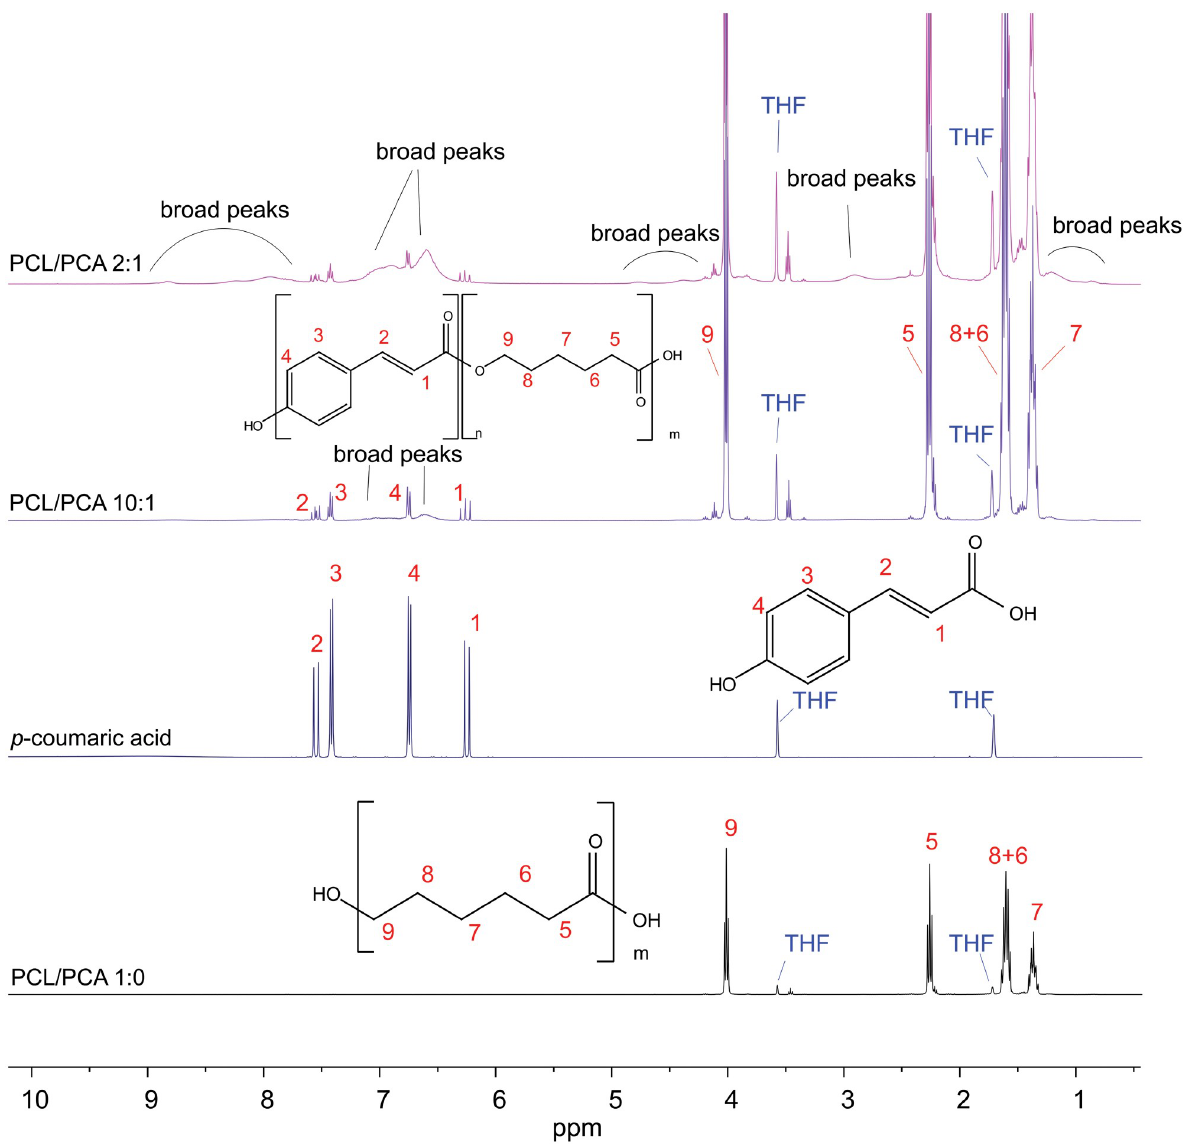
Fig 2. NMR characterization. 1 H-NMR spectra of PCL/PCA 1:0, 10:1, and 2:1 and p -coumaric acid in THF- d 8 . Assignments are included.